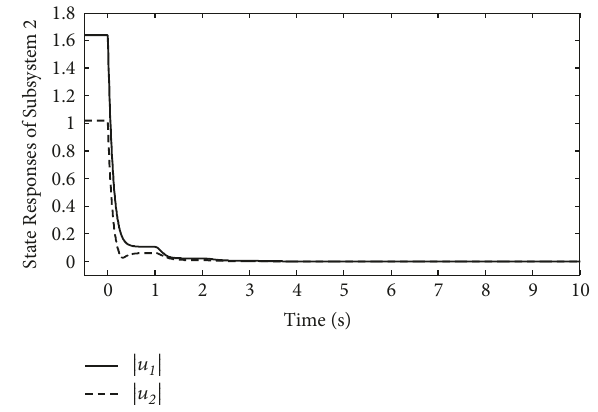
Figure 2: State curves of subsystem 2 in